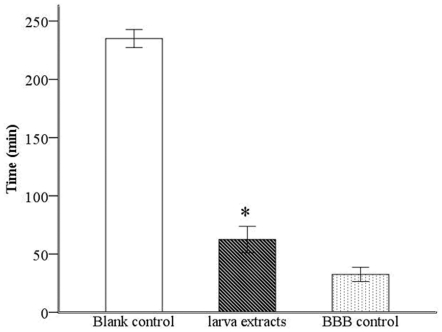
Analysis of percolation ability of BBB model with or without A. cantonesis larvae extracts.After larvae extracts were added to the BBB cell model, the time that the fluid level in the donor tank of Transwell started to drop was reported within 4 hours. The fluid level began to decrease significantly sooner in the larvae extract group. Data are presented as the mean ± SD of three experiments. * P<0.01, larvae extract group vs. Control group.